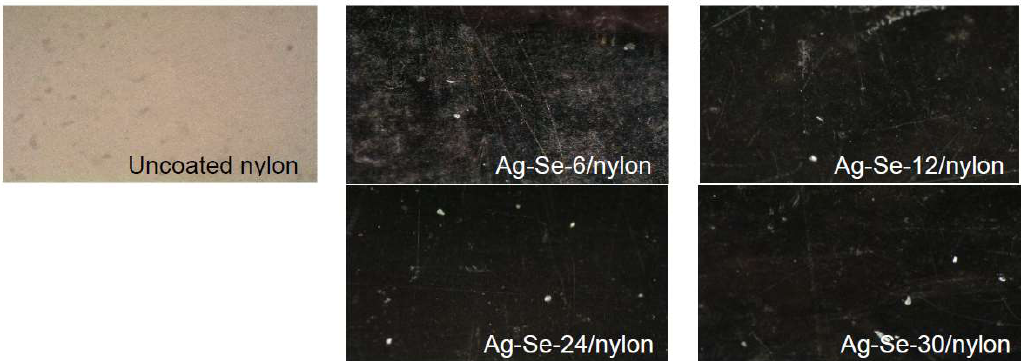
Figure 1. An image of uncoated nylon and obtained Ag–Se/nylon nanocomposites. Magnification 100×.